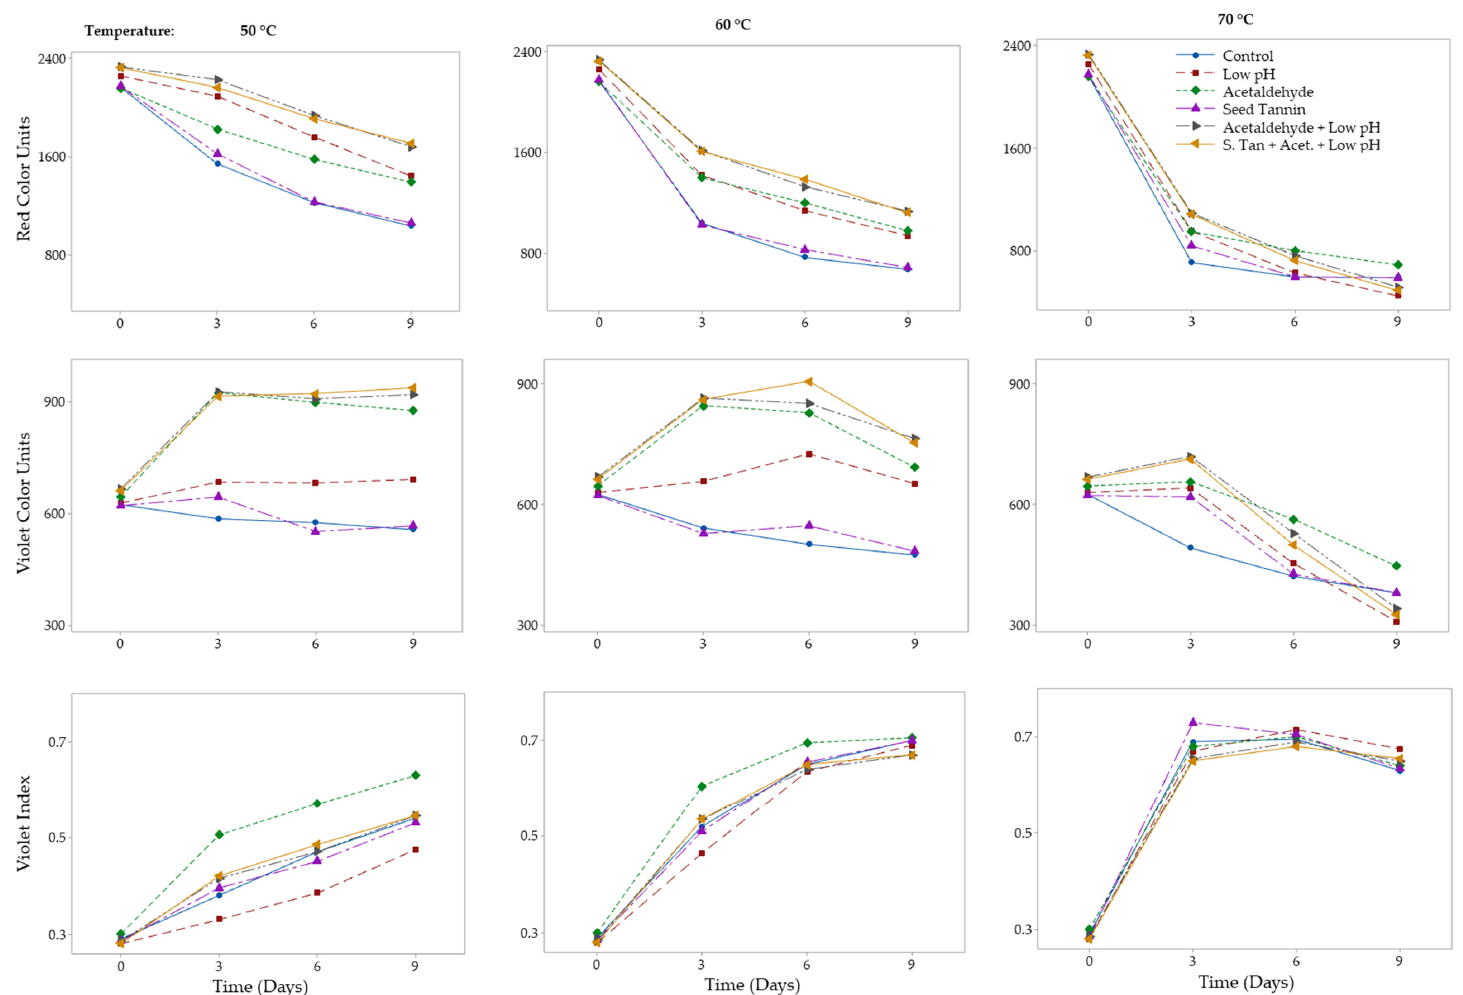
Figure 1. Effect of seed tannin, low pH, and acetaldehyde, individually or in combinations, on red and violet color stability (top and middle rows) and violet color index (bottom row) of Rubired concentrate derived from flash détente, heated at 50 °C (left column), 60 °C (middle column), and 70 °C (right column).